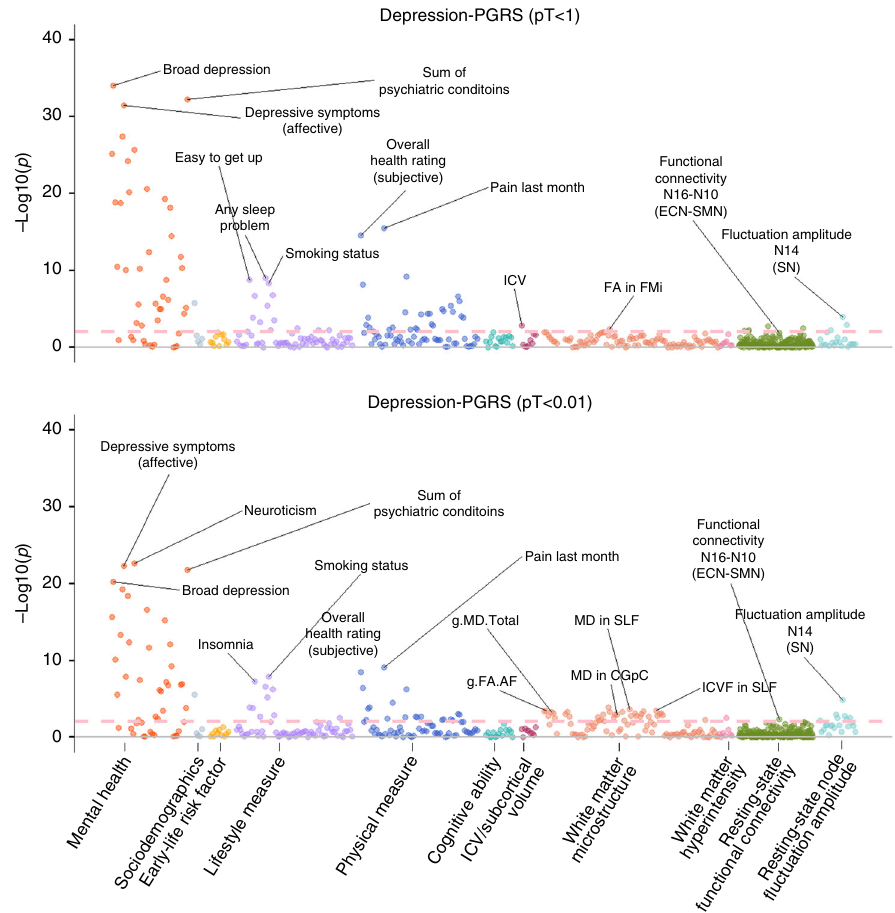
Fig. 1 Signi fi cance plot for all phenotypes for depression-PRS at p threshold (pT) < 1 and pT < 0.01. The x axes represent phenotypes, and the y axes represent the − log 10 of uncorrected p values of two-sided test for linear regression between depression-PRS and each of the phenotype. Each dot represents one phenotype, and the colours indicate their according categories. The dashed lines indicate the threshold to survive FDR correction. FDR correction was applied over all the traits and all depression-PRS (see “ Methods ” ). From left to right on the x axis, categories were shown by the sequence of mental health measure, sociodemographics, early-life risk factor, lifestyle measure, physical measure, cognitive ability, intracranial/subcortical volume, white matter microstructure, white matter hyperintensity, resting-state functional connectivity and resting-state fl uctuation amplitude. Representative top fi ndings are annotated in the fi gure. SN salience network, ECN executive control network, SMN sensorimotor network, FA fractional anisotropy, MD (for white matter microstructure) mean diffusivity, ICVF intra-cellular volume fraction, AF association fi bres, FMi forceps minor, SLF superior longitudinal fasciculus, CGpC cingulate gyrus part of